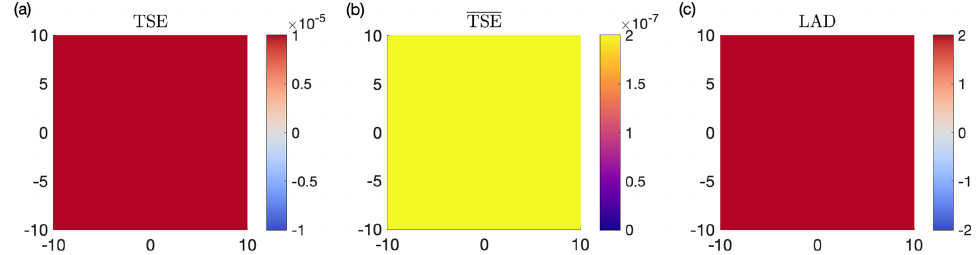
Figure A5. (a–b) TSEs and TSE show uniform stretching due to the uniform linear acceleration away from the origin. This matches the structure revealed by the uniform divergence field. (c) Lagrangian-averaged divergence is also constant, thus presenting the same pattern as TSEs and TSE. The LS is omitted as it is constantly zero in this shear-free flow.